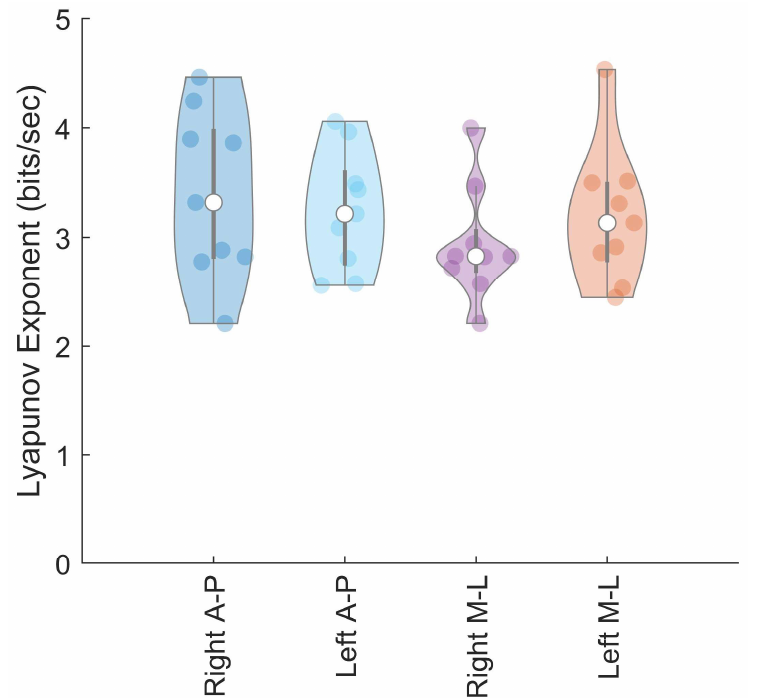
Figure 6. Violin plot of maximal Lyapunov exponent (bits/second) during the force control task. Median Lyapunov exponent indicated by open circle, interquartile ranges are represented by thick and thin vertical lines Shaded circles represent individual subject data. Data is reported for both the medial/lateral (M-L) and anterior/posterior (A-P) directions.